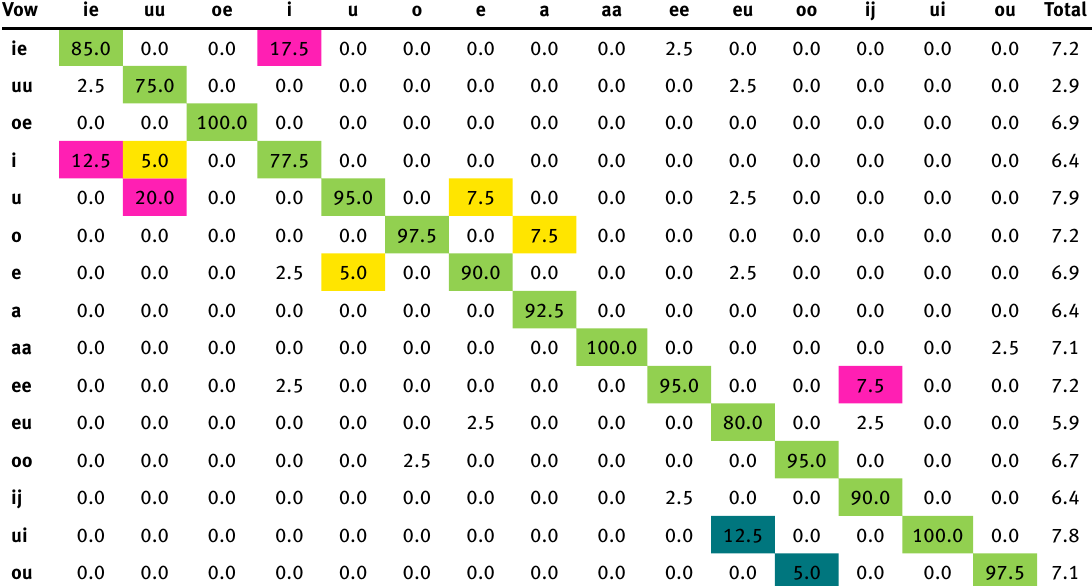
Table 8. Probability ratio of canonical (indicated in green) and non-canonical classifications for all 15 Dutch vowels produced by native Dutch speakers in the condition “Total” (F1, F2 + duration); target vowels in the columns, classified vowels in the rows, non-canonical classifications with deviations > 2.5% related to vowel height (in pink), vowel length (in turquoise), round- ing (in yellow) and diphthongization (in teal) are also indicated; Vow = target